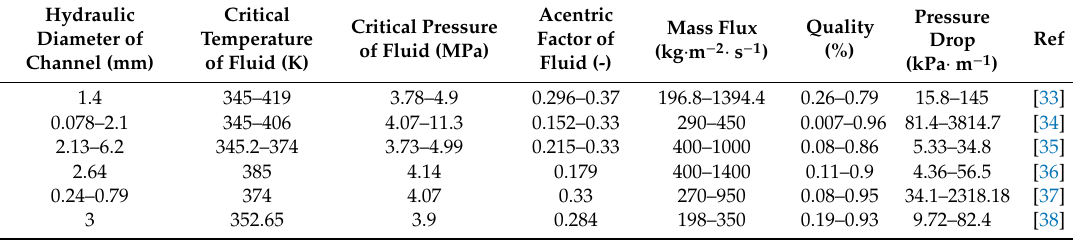
Table 2. Range and conditions of various experimental datasets.